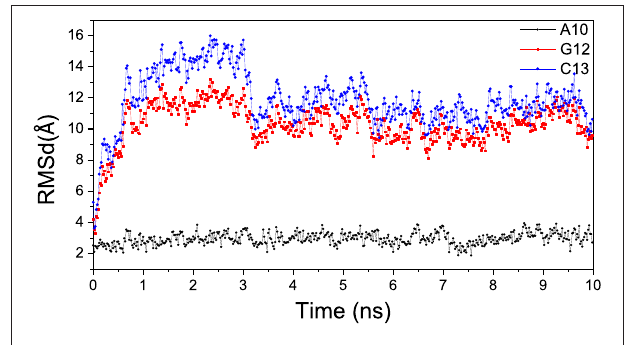
FIGURE 11 | Predicted 8 -values of bases for bound and apo-DNA/RNA hybrid, respectively.